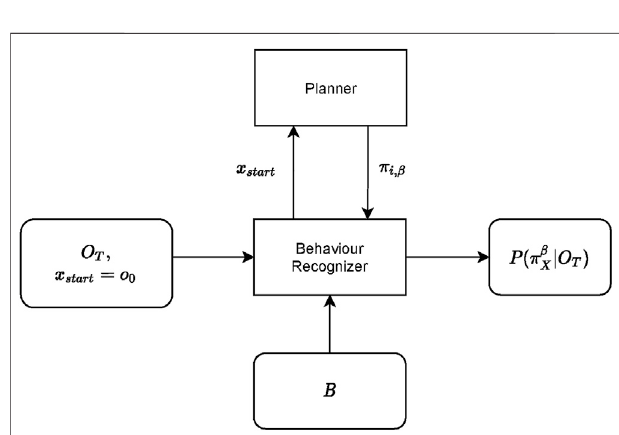
FIGURE 8 | Behaviour recognition